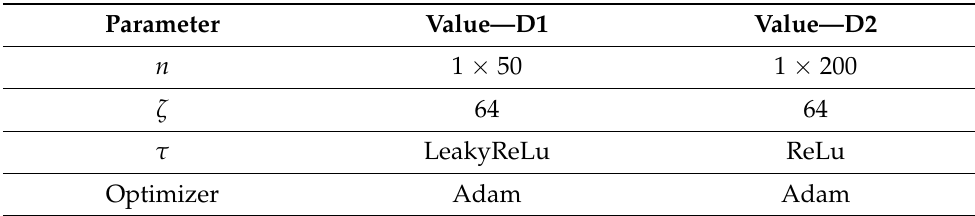
Table 3. Hyperparameters for the LSTM layers.